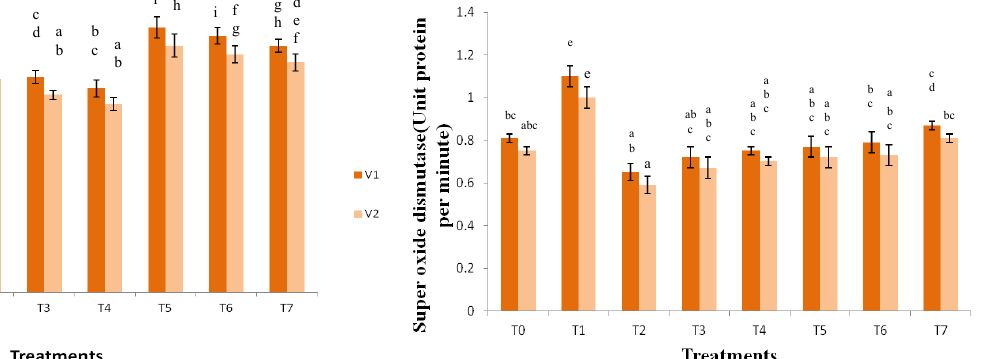
Fig. 3B: Effect of Azospirillum inoculation on soluble sugar of two canola varieties (v1 and v2) grown under drought stress. Where, To = Un-inoculated and well watered, T = Un-inoculated and drought exposed, T2 = Seed inoculated and well watered, T3 = Rhizosphere inoculated and well watered, T4 = Seed inoculated with heat killed inoculums and well watered, T5 = Seed inoculated and drought exposed, T6 = Rhizosphere inoculated and drought ex- posed, T7 = Seed inoculated with heat killed inoculums and drought exposed. And V1 = Rainbow, V2 = Con II.